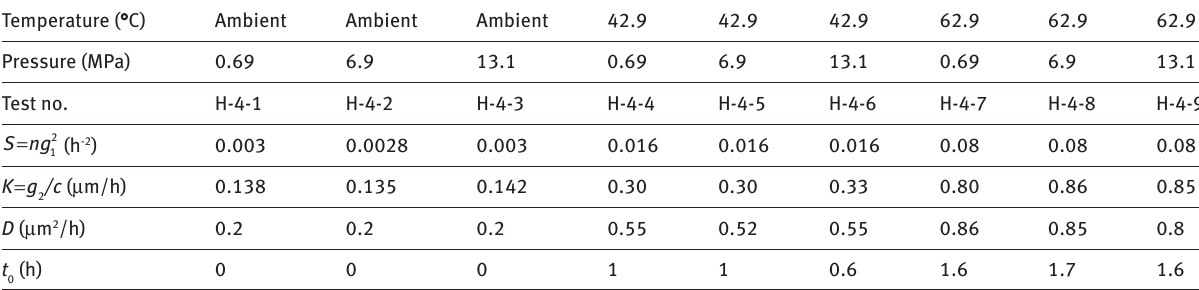
Table 4: Fitted model parameters at different curing conditions (Class H cement).